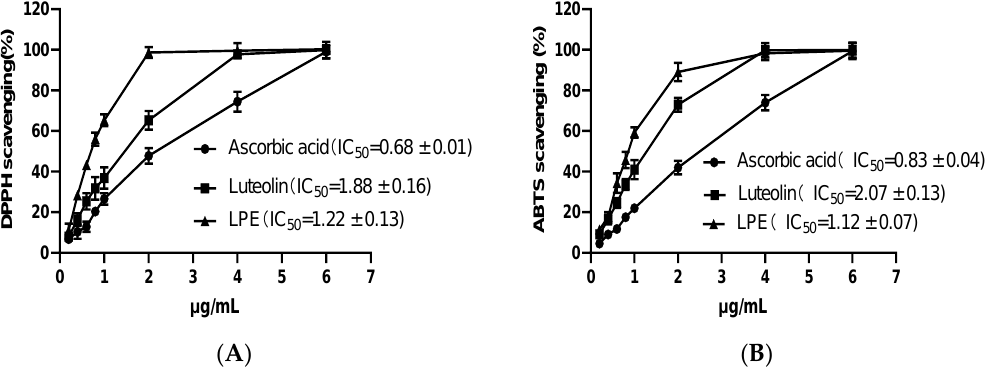
Figure 1. DPPH and ABTS assays of radicals scavenging activity of LPE: ( A ) DPPH radical scavenging activities; ( B ) ABTS radical scavenging activities. Values are expressed as the mean of triplicate experiments ± standard error.